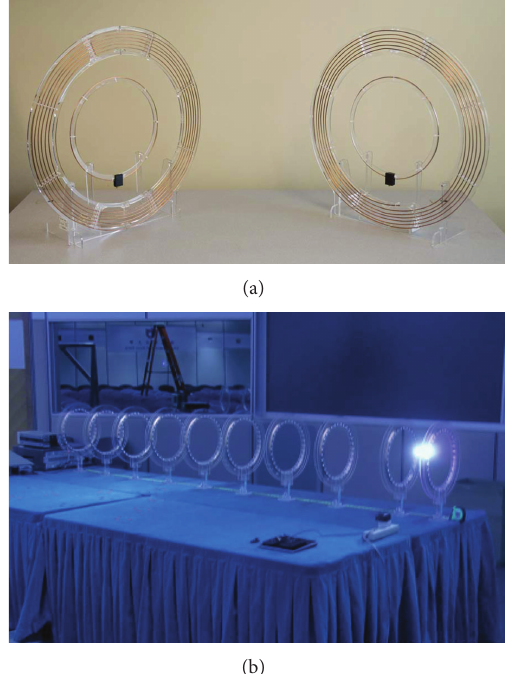
Figure 1: (a) Practical coupled resonators [3]. (b) Practical DCR configuration with ten coupled resonators